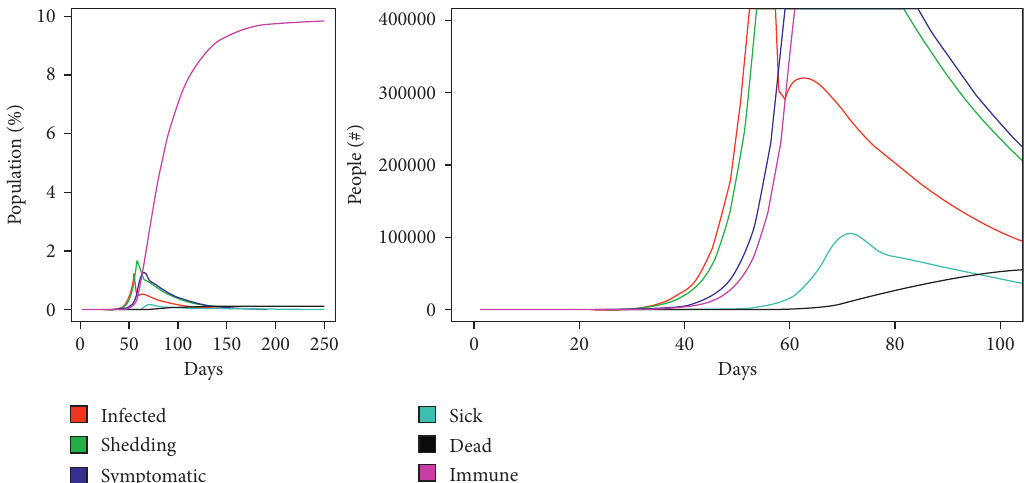
Figure 8: Model simulations implementing social distancing with R